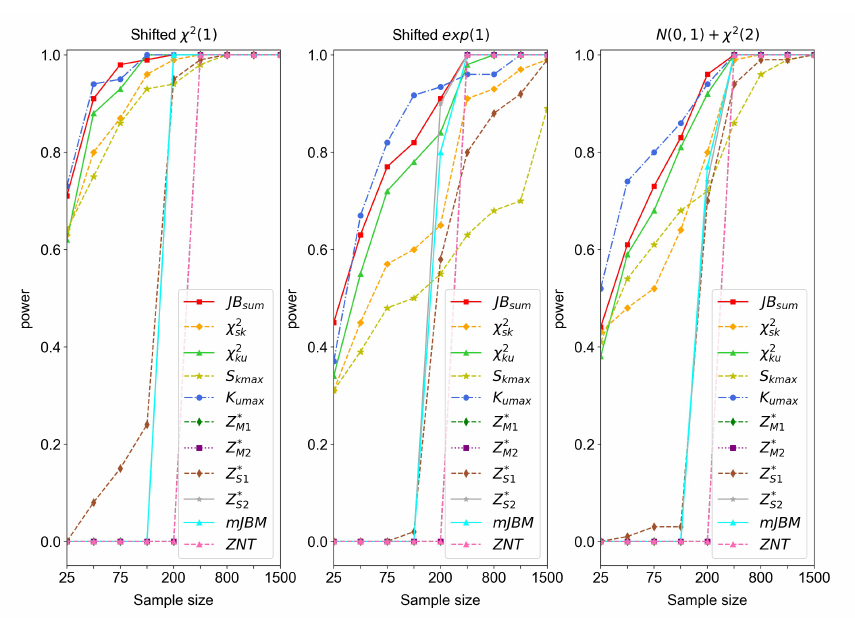
Figure 5. Empirical power of proposed PC-type JB testing compared with other methods ( p =